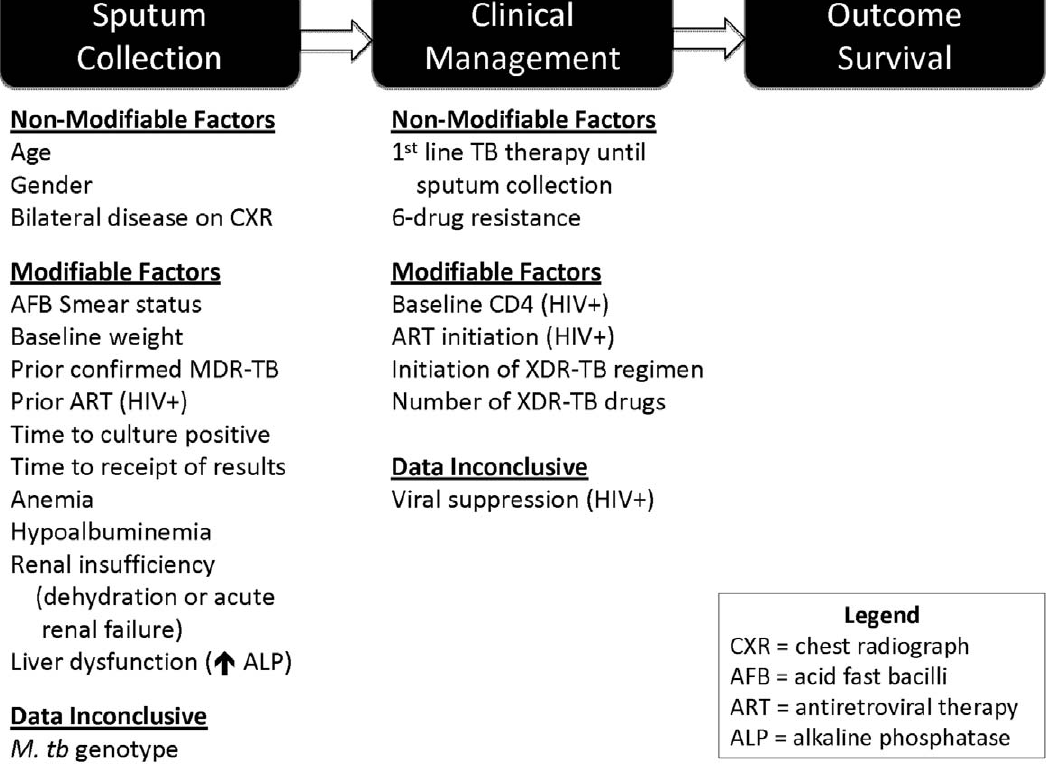
Figure 2. Modifiable & Non-Modifiable Clinical Characteristics of XDR-TB Patients.